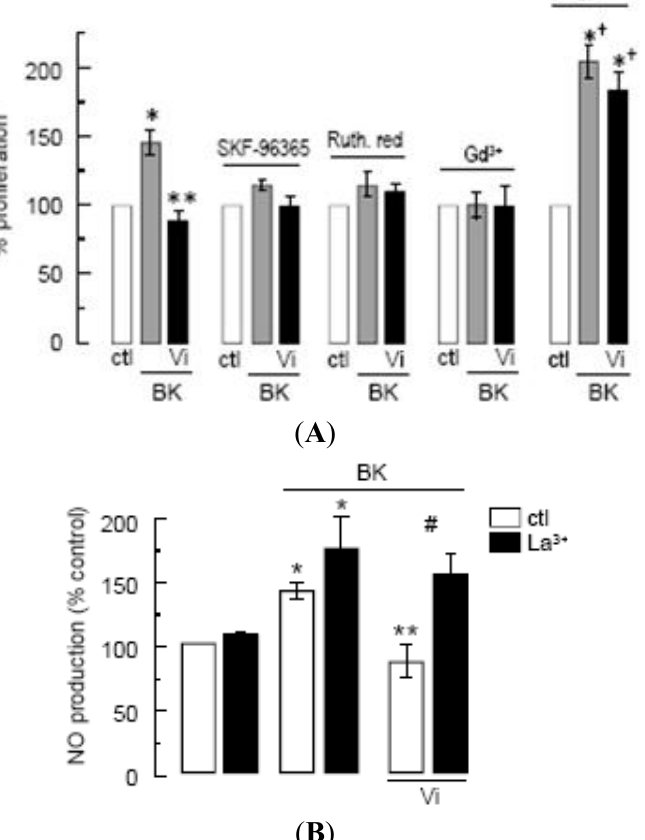
Figure 5. Vasoinhibins interfere with TRPC-mediated Ca 2+ entry to modulate the BK-stimulated NO production and proliferation in